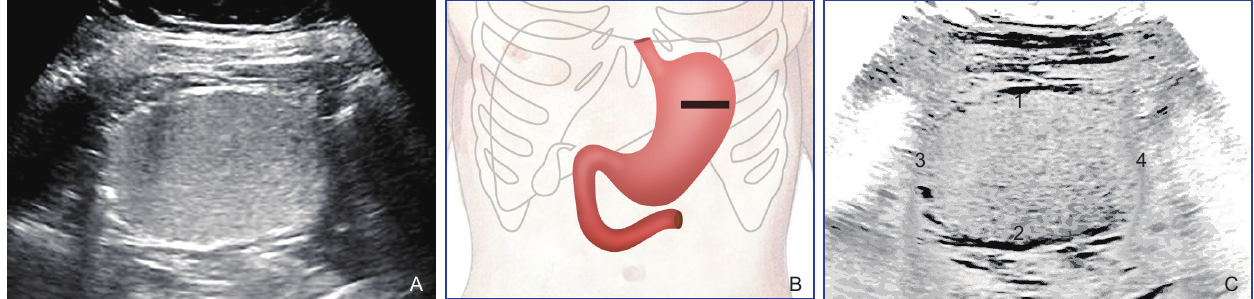
Figure 7 Short-axis section of the middle and upper part of the gastric body ultrasound images and scan schematic diagram of the section (scan under xiphoid process on the left side). A, Ultrasound image; B, Scan the schematic diagram; C, Schematic diagram of ultrasound (1, Anterior wall of the stomach; 2, The posterior wall of the gastric body; 3, Lesser curvature of the gastric body; 4, Greater curvature of the gastric body)